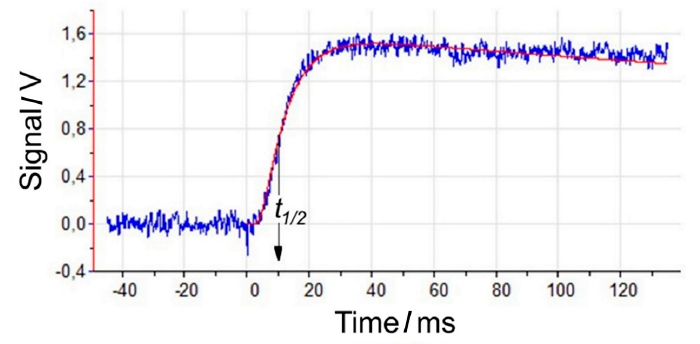
Figure 3. Time variation of LFA signal measured by IR detector corresponding to the temperature of the top surface of the sample. Blue curve—as measured for VANT + graphite sample, read curve—approximation with Cowan correction.